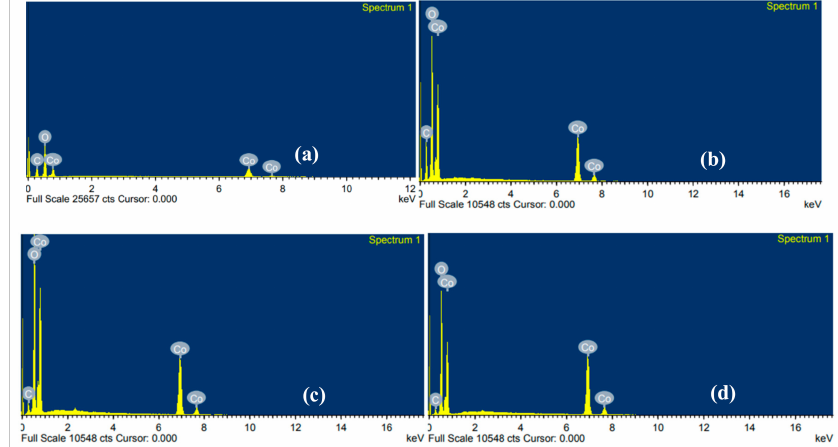
Figure 5. Composition of elements in ( a ) CN-R, ( b ) CN-300, ( c ) CN-400, and ( d ) CN-500.